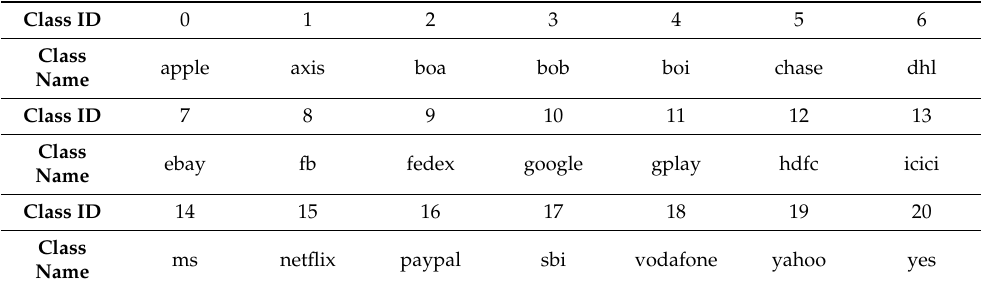
Figure 14. Confusion matrix for the best performance. Table 3. Class name and class